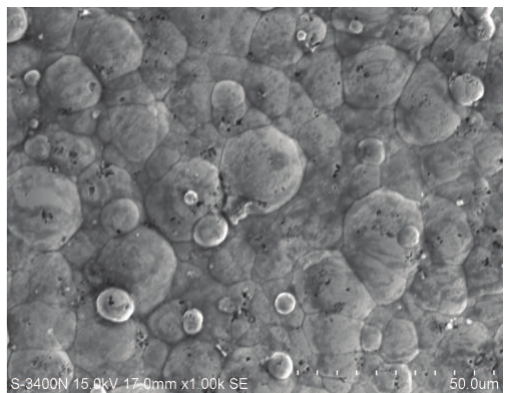
Figure 5: SEM micrograph (1000 × ) of electroless Ni–P coated on magnesium(Mg)compositereinforcedwithmultiwallcarbonnano- tube (MWCNT) without surfactant and